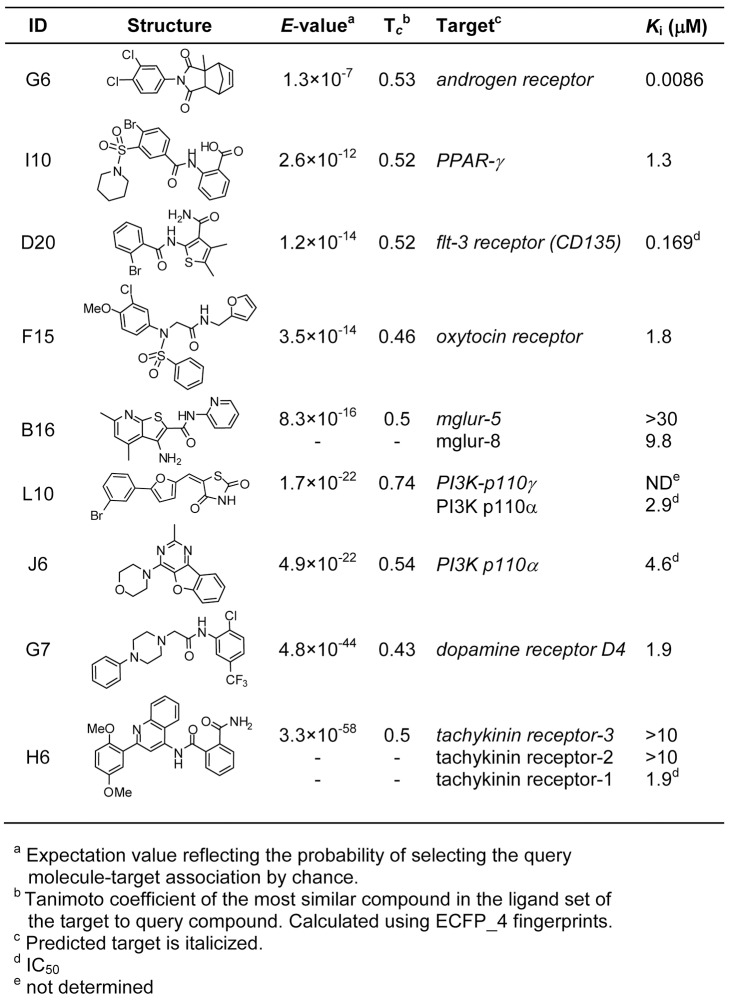
SEA predictions that were confirmed by in vitro testing.